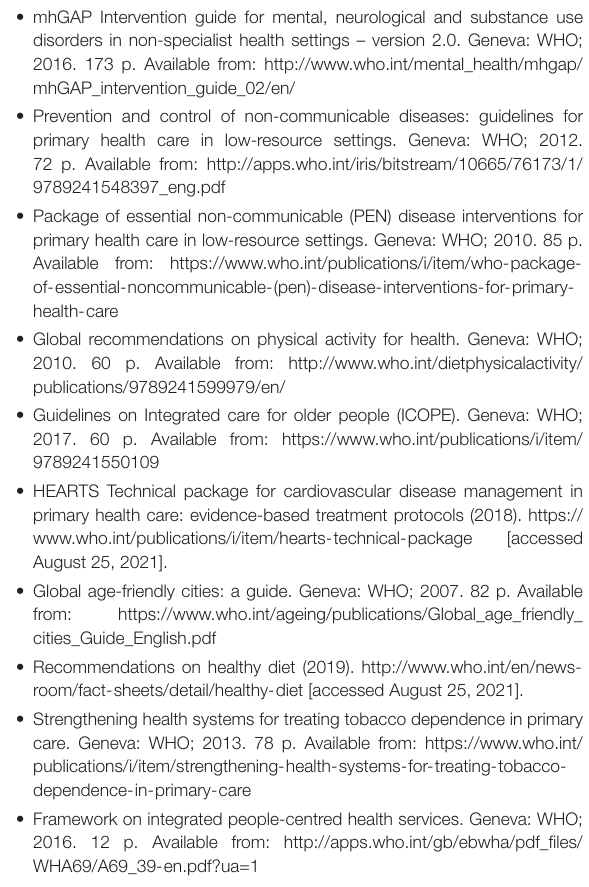
headings: lifestyle and behaviour interventions, interventions for physical health conditions and specific interventions ( Table 1